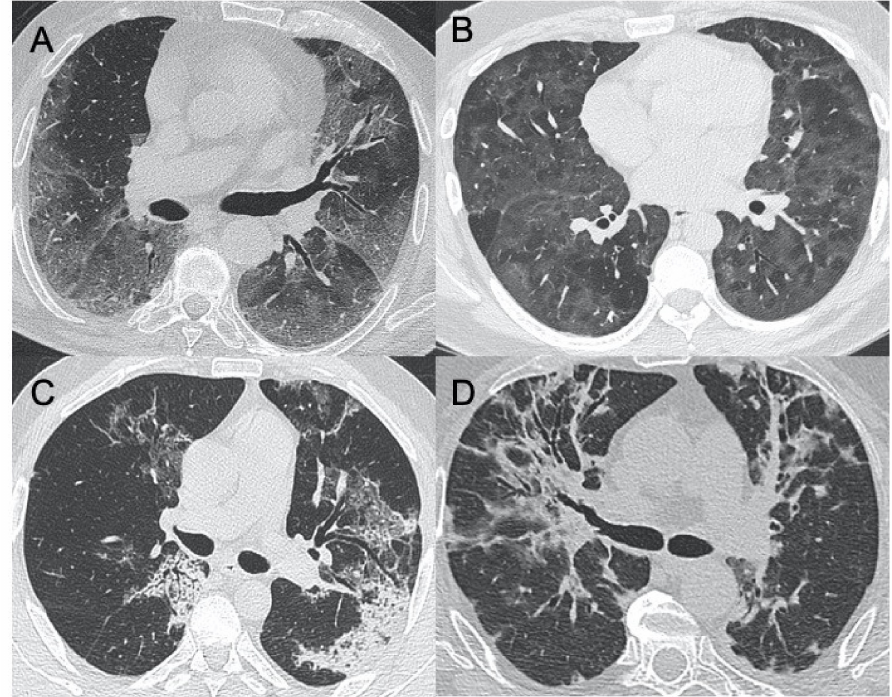
Figure 2. HRCT (High resolution computed tomography) in COVID-19 pneumonia. Diffuse ground- glass opacities involving both lungs ( A ) and with peri-lobular pattern ( B ) in the acute phase of the infection. ( C , D ) show two cases of sub-acute interstitial pneumonia, with decrease in ground- glass opacities and the presence of subpleural focal consolidations and thickening of the interlobu- lar/intralobular